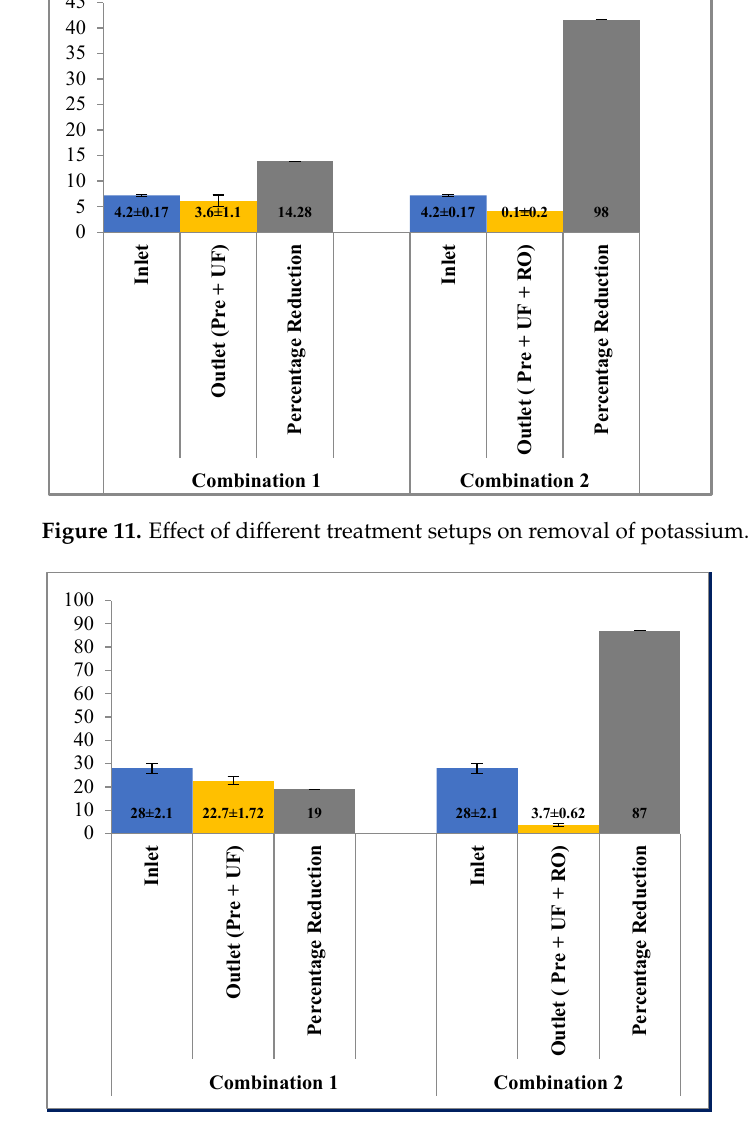
Figure 12 . Effect of different treatment setups on removal of sodium .